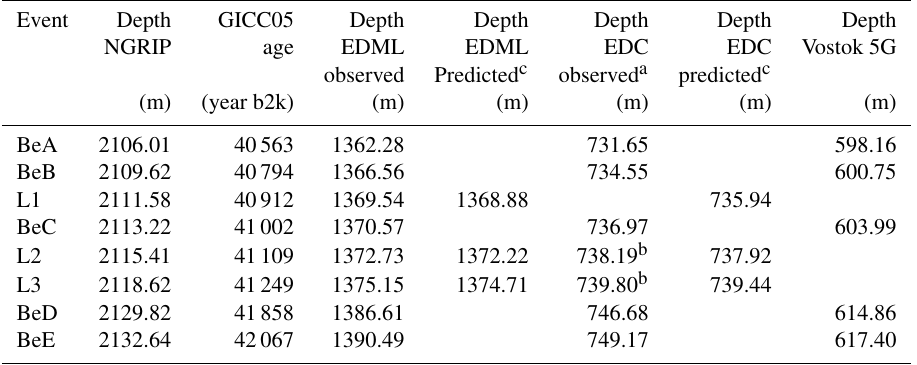
Figure 2. Beryllium 10 fluxes after synchronization to NGRIP (GICC05) using the Match protocol (Lisiecki and Lisiecki, 2002) for EDC and EDML, or using five tie points (A–E) and AnalySeries (Paillard et al., 1996) for Vostok. For each site the detailed fluxes (histograms calculated using 11cm accumulation rates for NGRIP, 55cm for EDC, 50cm for EDML and 10cm for Vostok) and results smoothed with a 50-year binomial filter (curve) are shown. Table 1. The first two columns report the depth and GICC05 ages (Svensson et al., 2008) of our 10 Be tie points (BeA–BeE) and the volcanic markers (L1–L3) of Svensson et al. (2013) at the NGRIP site (see text). The following columns provide the depths of corresponding depths for EDML, EDC and Vostok ice cores either observed or